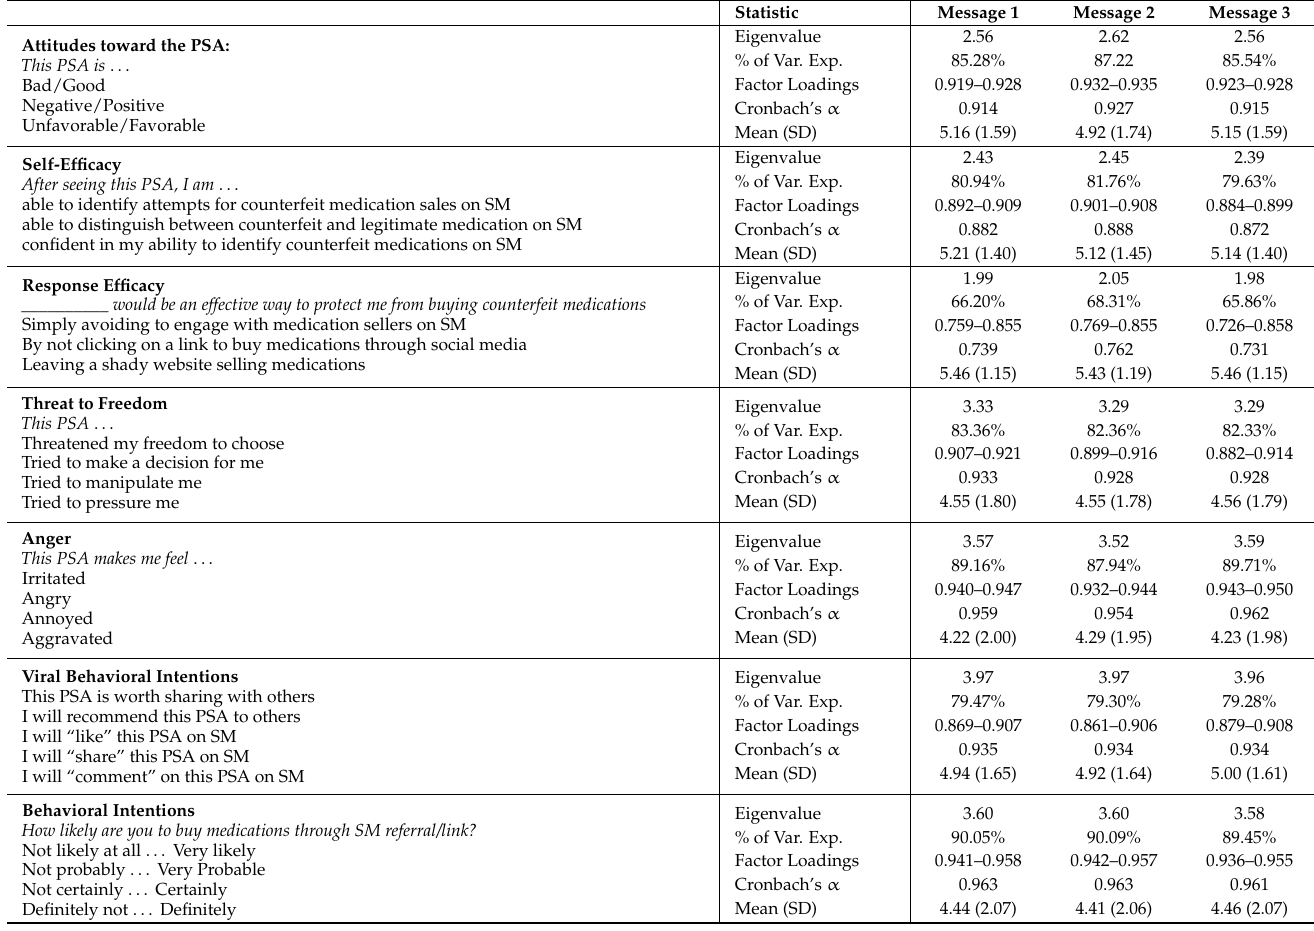
Table 1. Factor and reliability analysis results for all dependent